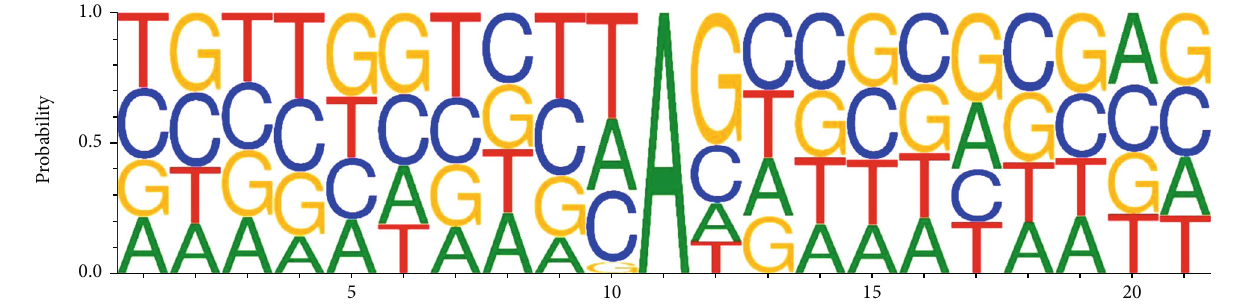
Figure 4: Neighborhood sequence preferences of nucleotides for RNA editing